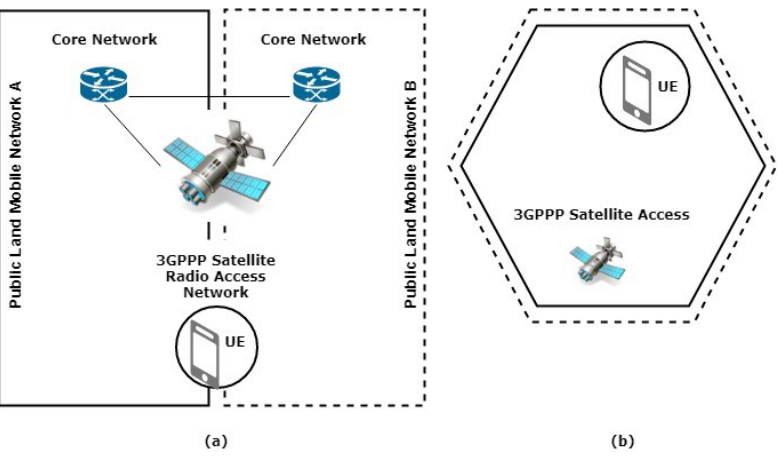
Figure 2. Multi Operator Core Network sharing architecture with satellite radio access network: ( a ) architecture, ( b )